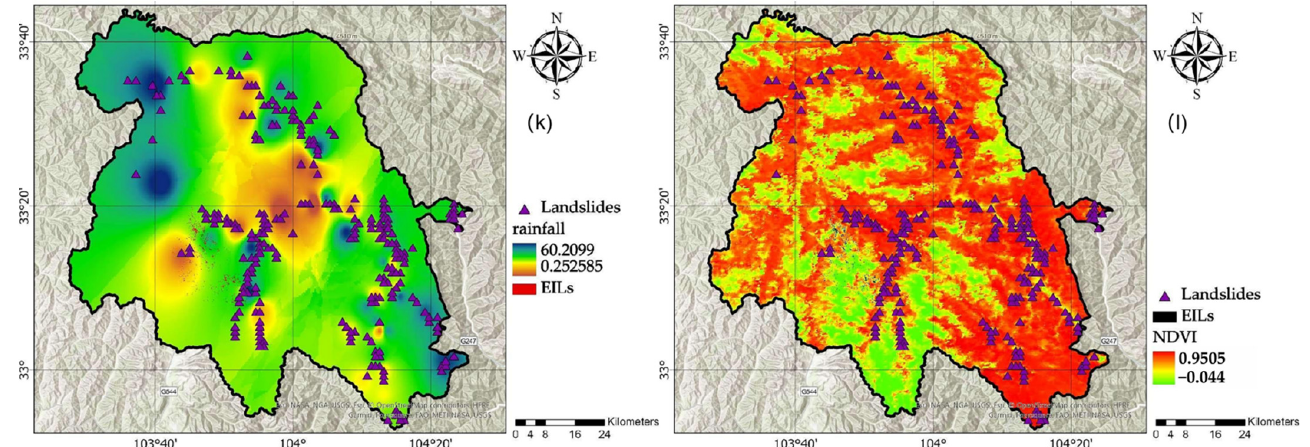
Figure 3. Influencing factors in Jiuzhaigou. ( a ) Elevation; ( b ) slope; ( c ) plan curvature; ( d ) profile curvature; land use ( e ) aspect lithology; ( f ) TWI; ( g ) distance to a river; ( h ) distance to a fault; ( i ) land use and land cover; ( j ) lithology; ( k ) rainfall and ( l ) NDVI.